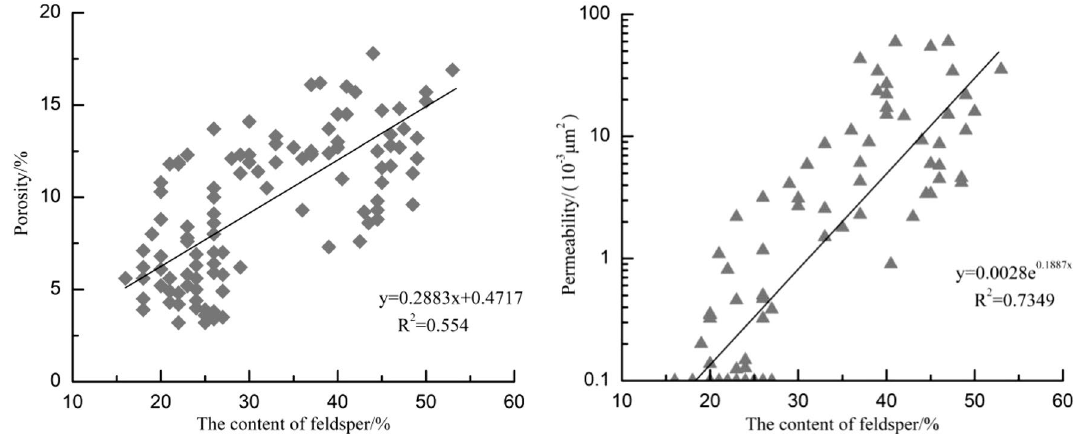
Fig. 13 Variation in physical properties with feldspar